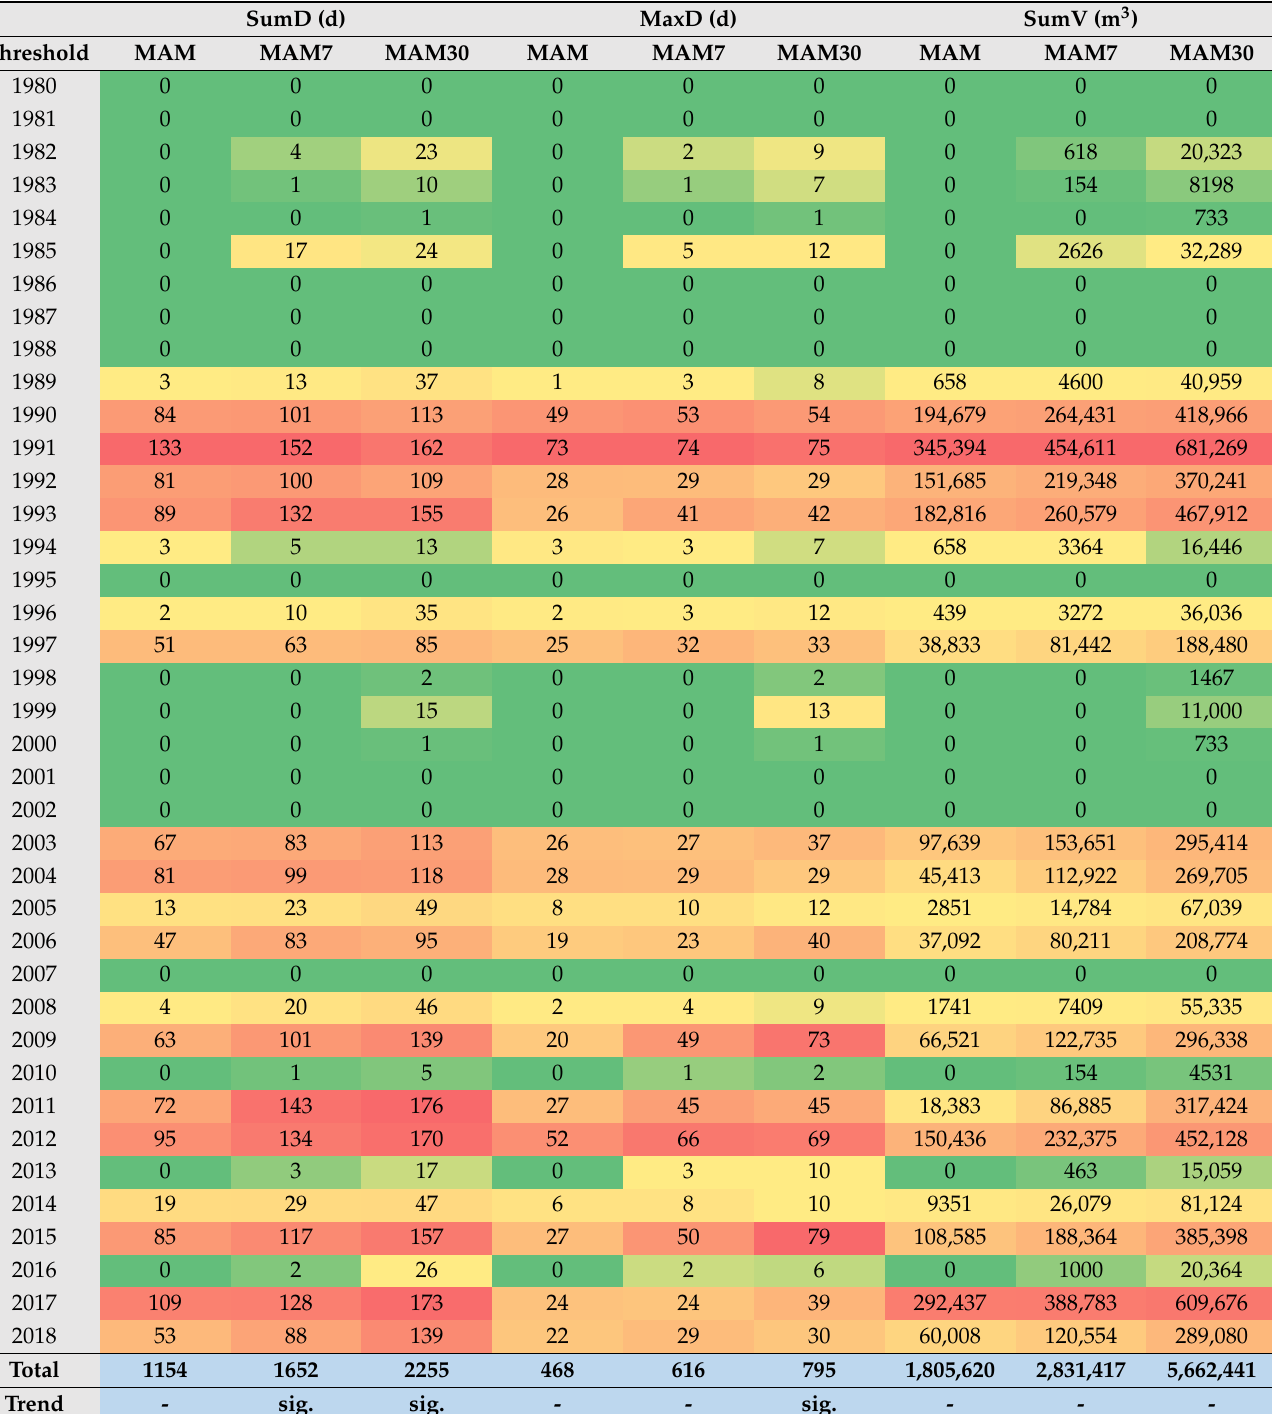
Table 8. Characteristic values FIS out